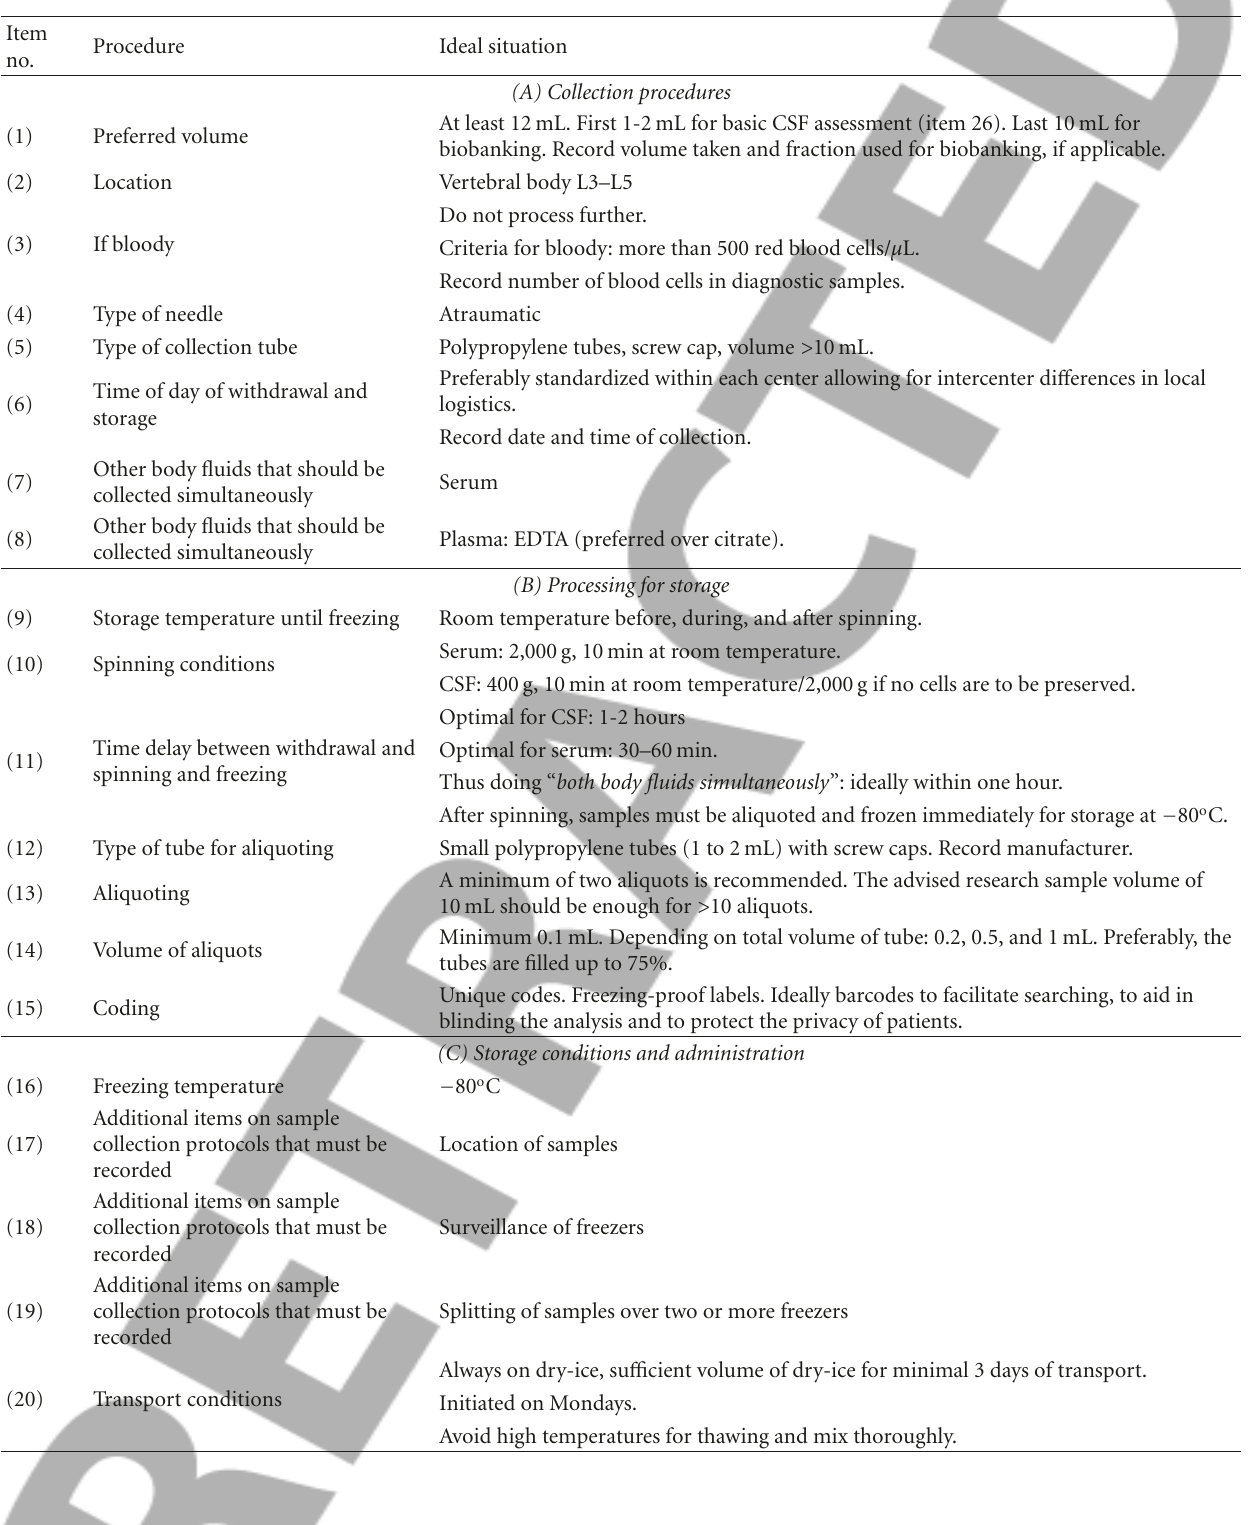
Table 2: Guidelines for procedure of CSF